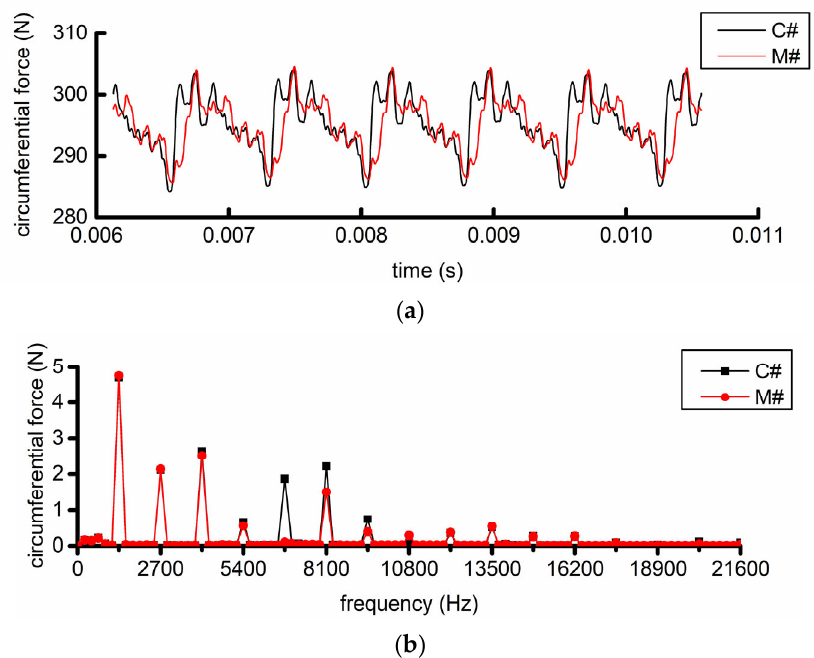
Figure 14. Circumferential force of R1 rotor blade. ( a ) Time domain ( b ) Frequency domain.